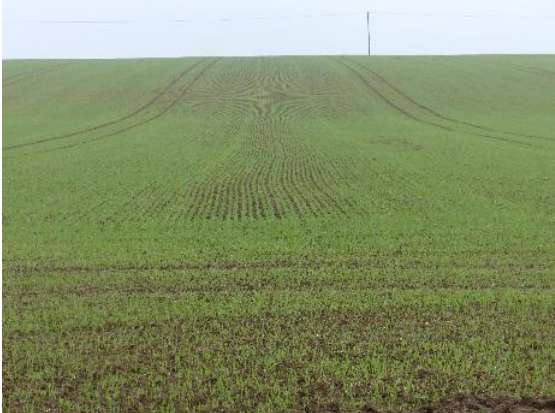
Figure 6. Large-block arable land (Moyzeová, 2020).